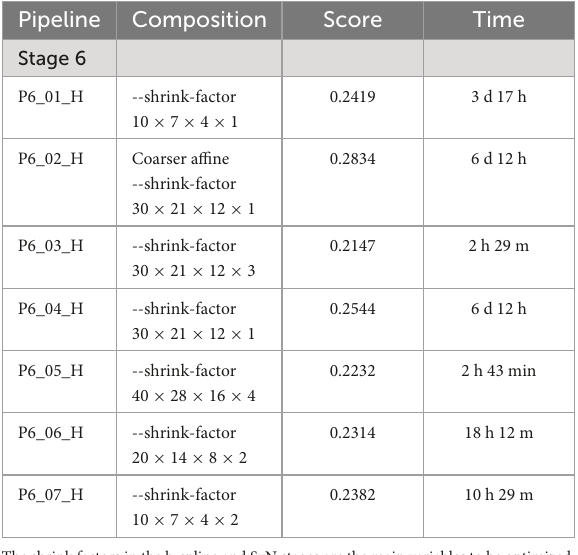
TABLE 3 Optimization of pipeline @ 15 µ m